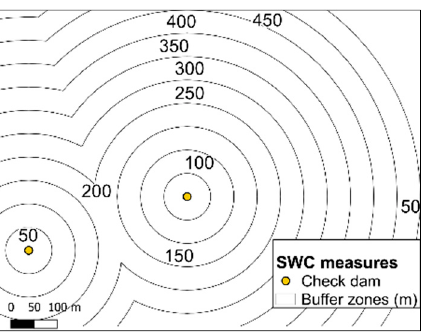
Figure A4. LandTrendr. Fitted segments into an annual maximum NDVI time series.